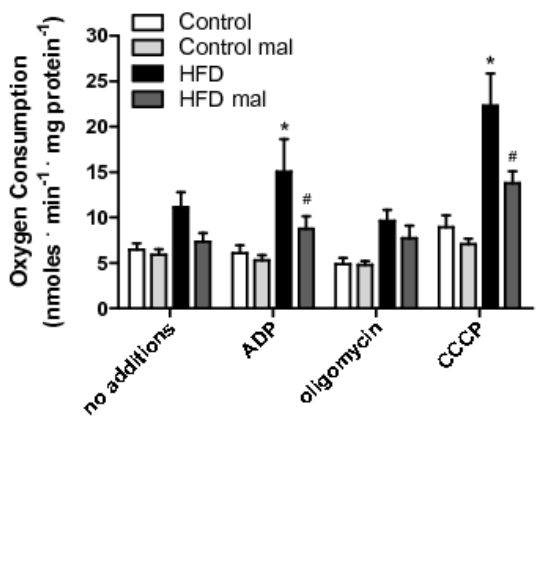
Figure 4. Mitochondrial respiration supported by palmitoyl-carnitine is enhanced in HFD. Mitochondria were incubated under the conditions described for Figure 3, substituting succinate for 50 μM palmitoyl-carnitine. Malonyl-CoA (mal, 50 μM) was present where indicated. *, p < 0.05 versus control, # , p < 0.05 versus HFD in the absence of malonyl-CoA, n = 6 per group. doi: